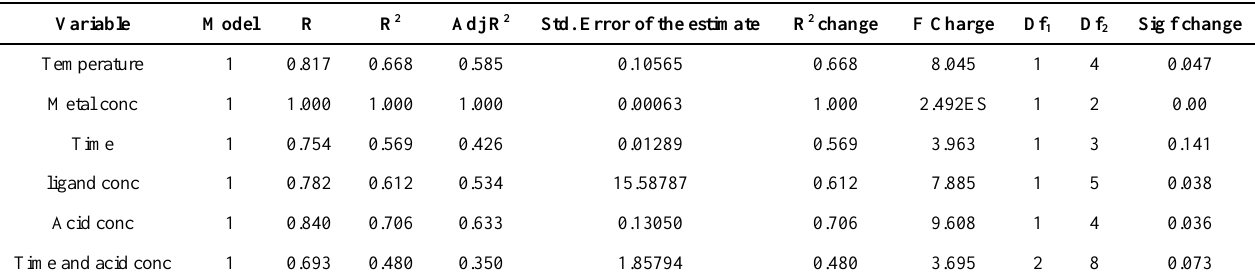
Table 5. Coefficient of correlation between the variables and amount of Fe (III) H 2 SAL extracted